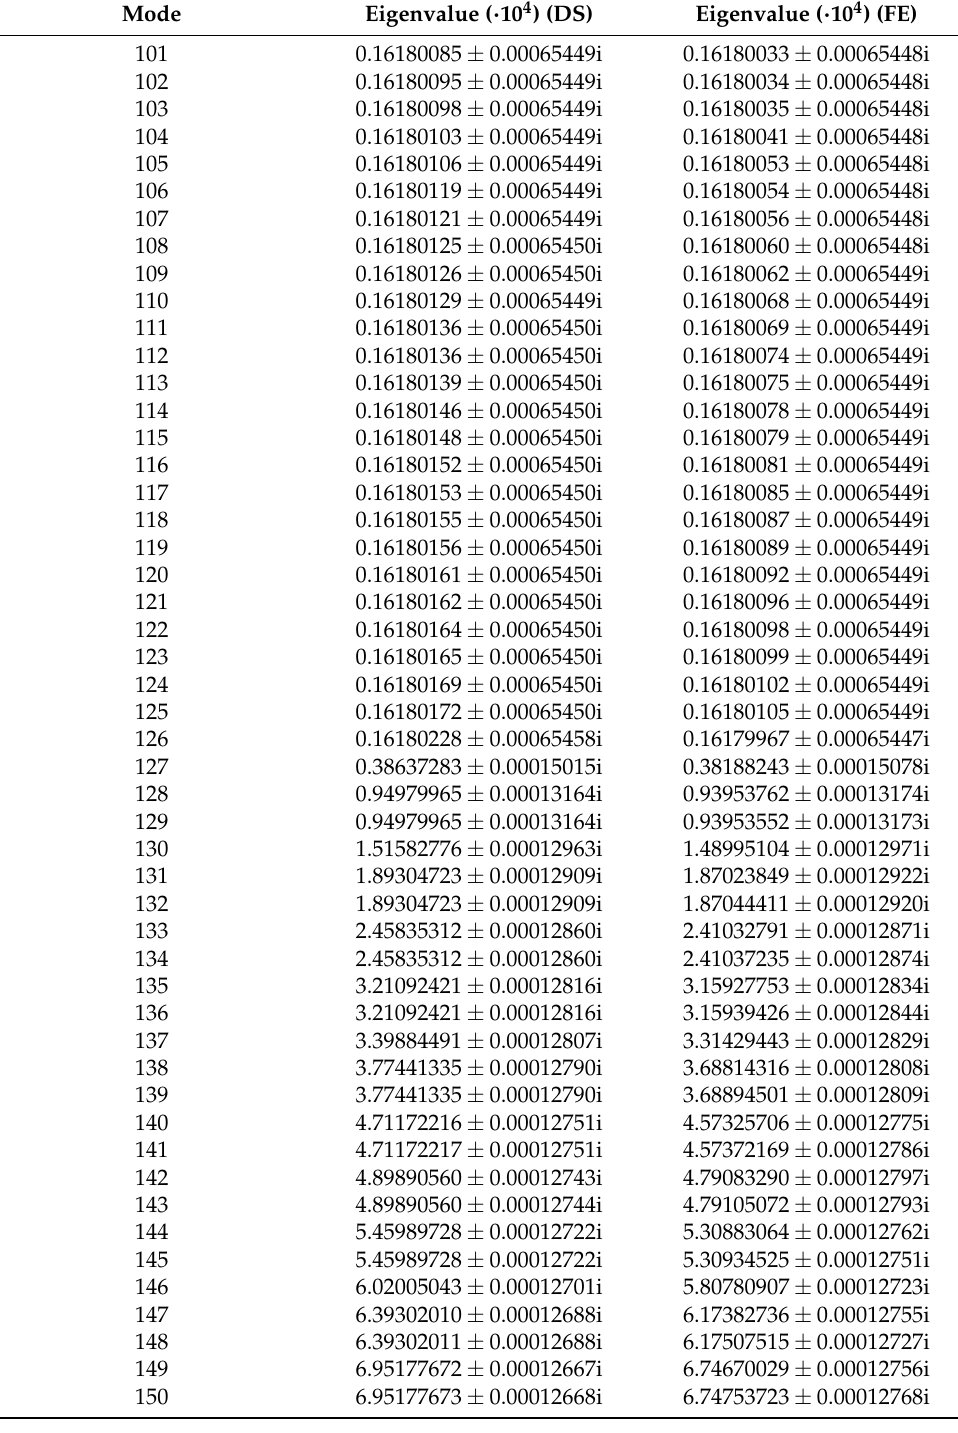
Table A3. Complex eigenvalues (from 101 to 150) of the LRMP in Figure 3 with 2-DOF resonators, computed by means of the proposed dynamic-stiffness approach (DS) and the FE method